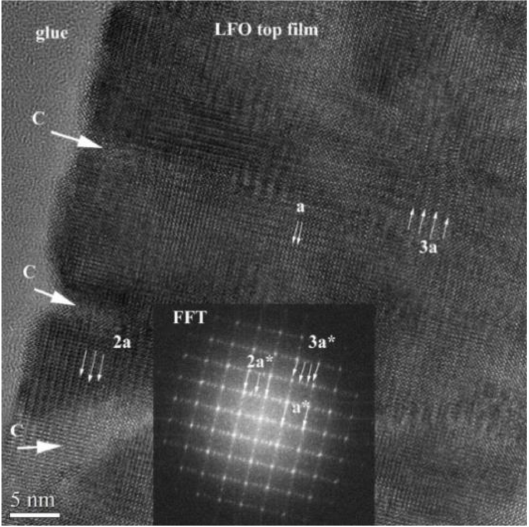
Figure 10. High-resolution XTEM image of the top of the LFO film. Inset is the FFT pattern performed on the image area. (a* is denoted as the presence of the superstructure in FFT pattern analyses of the zone defined by 2a and